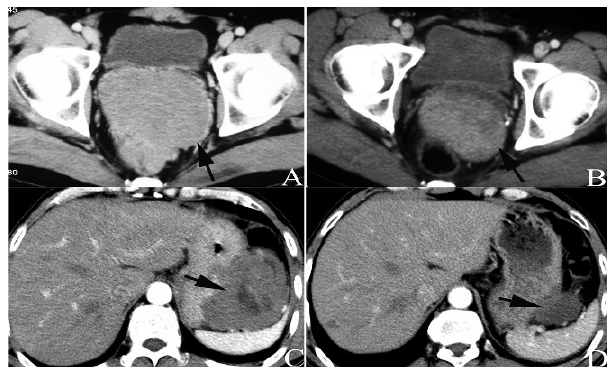
Figure 4 - Based on the CT images, the IM responses were rated as partial. Patients no. 6 (AB) and no. 8 (CD) were first diagnosed with combined liver metastases (black arrows in A and C) and signs of liquefactive necrosis in the metastases and tumors were both observed (white/black arrows in B and D) at two months after initiation of